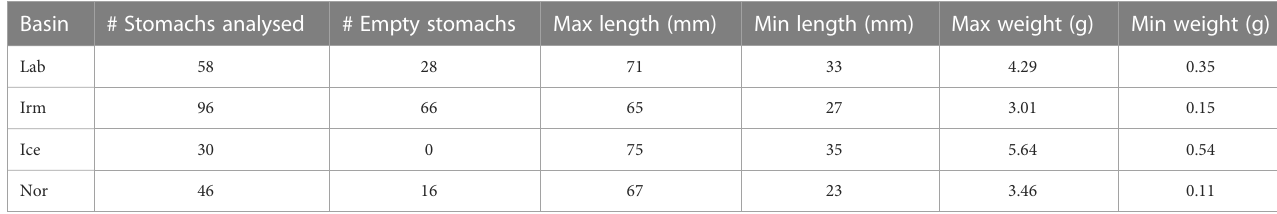
TABLE 2 Overview of number Benthosema glaciale stomachs analyzed per basin, number of empty stomachs, the standard length (SL) and weight ranges (minimum and maximum) in millimeter (mm) and gram (g) respectively. Basin # Stomachs analysed